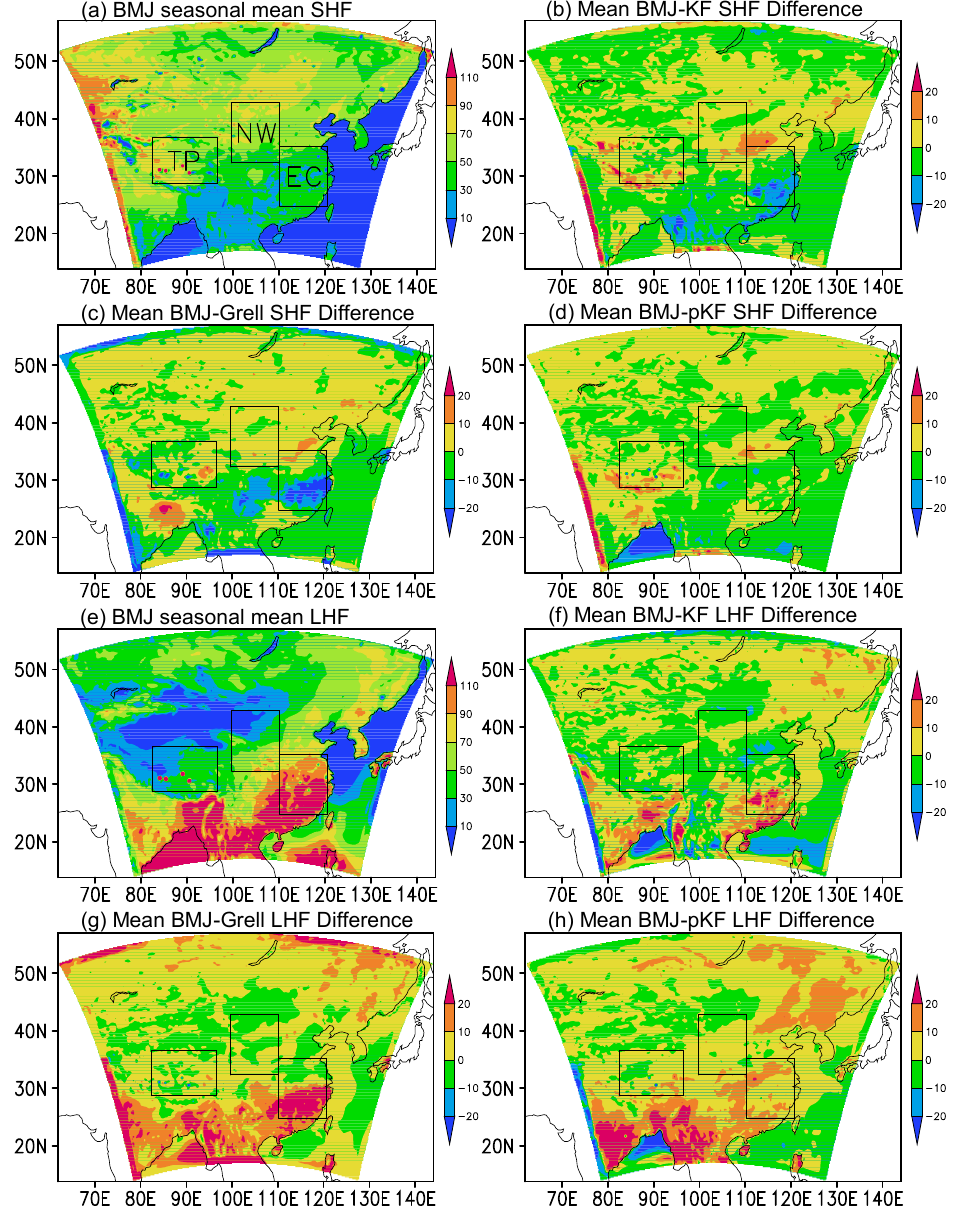
Figure 4. Ensemble seasonal mean distributions of sensible heat flux (SHF), latent heat flux (LHF), and their differences (units: W m − 2 ).